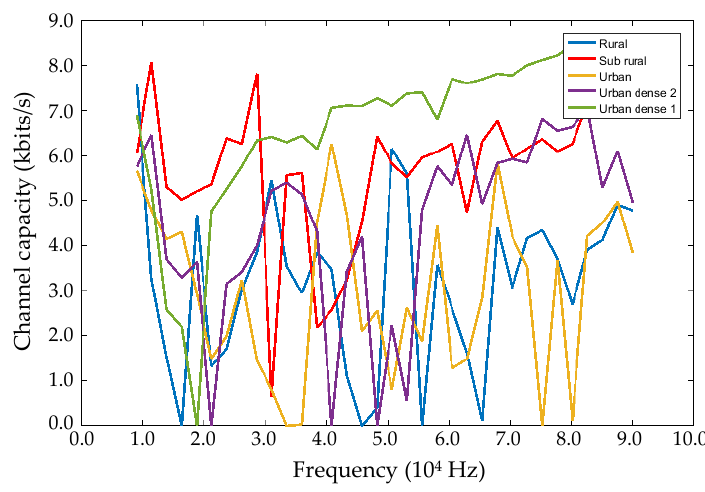
Figure 19. Estimation of the channel capacity in the CENELEC A band.